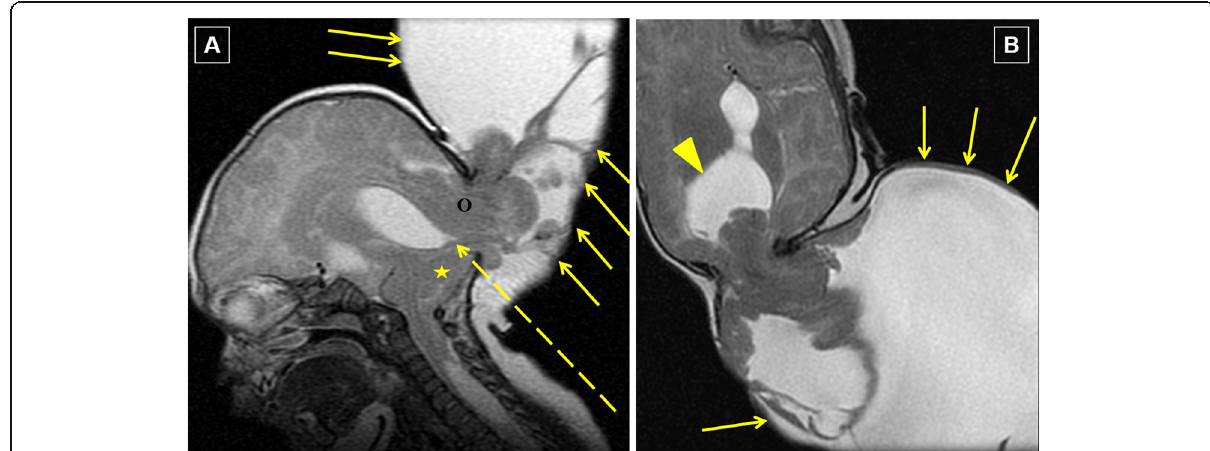
Fig. 7 Giant occipital encephalocele. ( a ) (T2-weighted sagittal) and ( b ) (T2-weighted axial) images: Note a large hernial sac (arrows) with herniation of posterior fossa content (star) and occipital lobes (O). There is herniation of the occipital horns into the hernial sac (dotted arrow). The size of the sac is larger than the size of the head. Note the deformed appearance of the lateral ventricle (arrowhead)